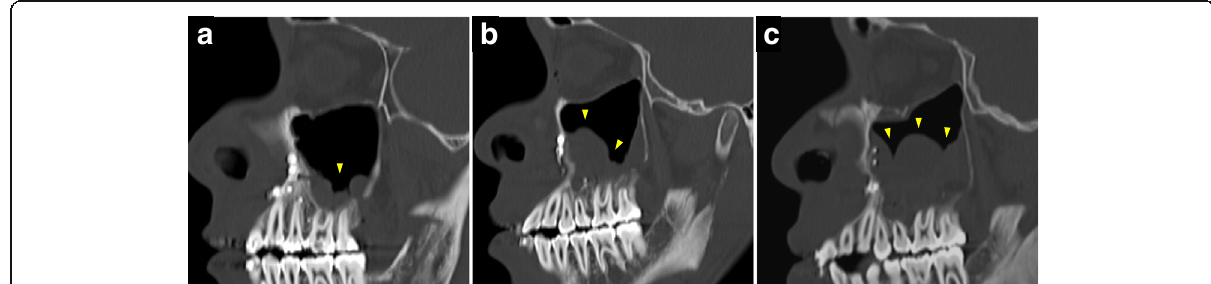
Fig. 1 Grading of maxillary sinus mucosal thickening on MDCT images. a Grade 1, thickening of the maxillary sinus occupying the maxillary sinus volume is one third or less. b Grade 2, thickening occupying one third to two thirds of the maxillary sinus. c Grade 3, thickening occupying more than two thirds of the maxillary sinus